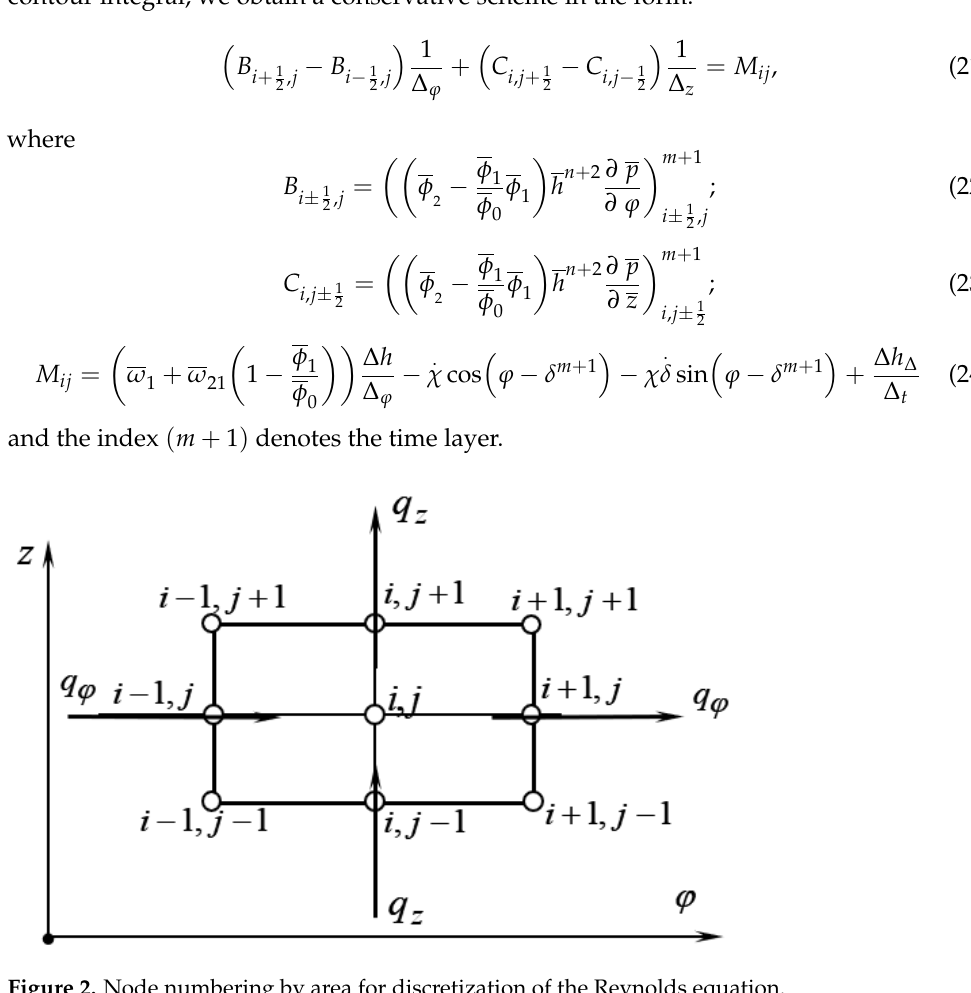
Figure 2. Node numbering by area for discretization of the Reynolds equation.